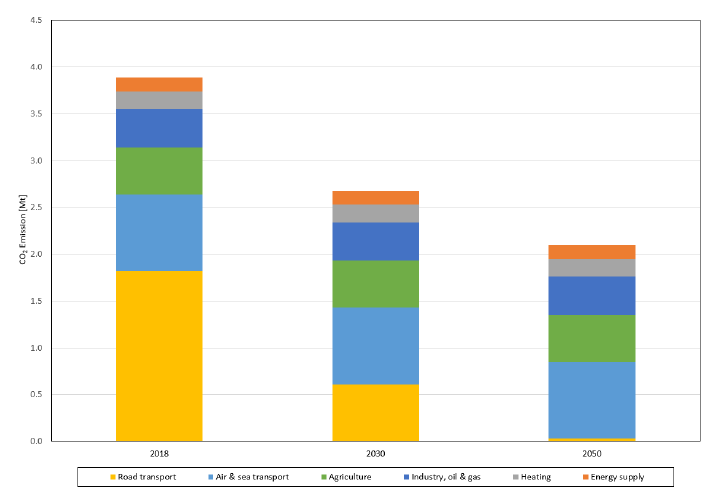
Figure 6. CO 2 emissions